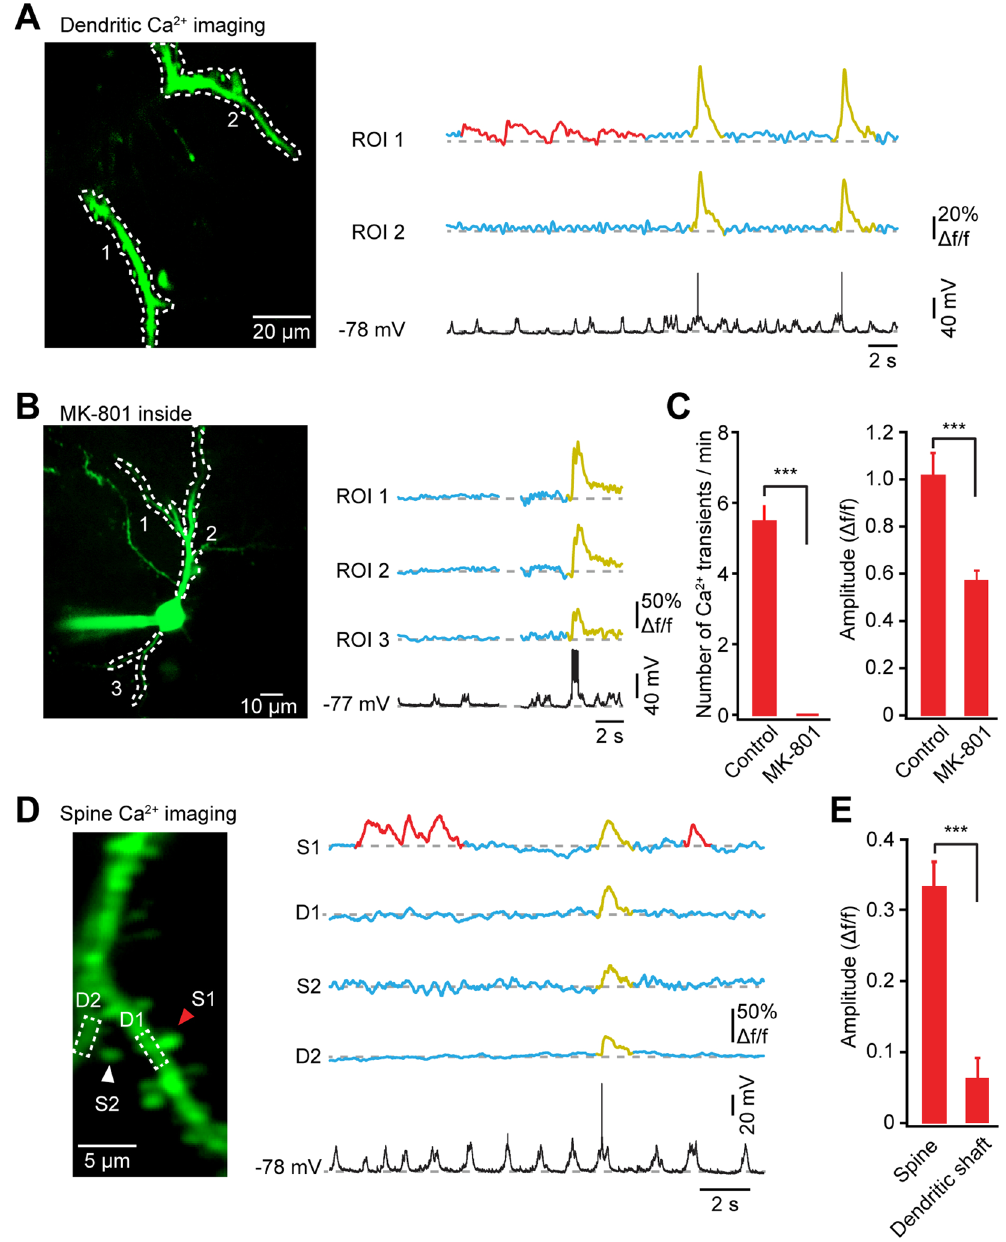
Figure 5. Local Ca 2 + signals associated with synaptic activation in dendrites and spines. ( A ) Subthreshold local dendritic Ca 2 + signals. Left, two-photon image with ROIs from the same neuron as in Fig. 3A. Right, local dendritic Ca 2 + signals (in red) and AP-associated dendritic Ca 2 + signals (in yellow), and their corresponding electrical signals recorded from the soma (in black). (B) Blockade of local dendritic Ca 2 + signals by intracellularly applied MK-801 (1 mM). Note that AP-associated Ca 2 + signals were still present, obtained from the same neuron in Fig. 4D. ( C ) Comparison of number of subthreshold dendritic Ca 2 + transients (Left) and amplitude of single AP-associated dendritic Ca 2 + transients (right) without (control: n = 10 dendrites from 5 neurons) and with MK-801 ( n = 8 dendrites from 3 neurons). Wilcoxon rank sum test, *** P < 0.001. Error bar shows SEM. (D) Subthreshold spine Ca 2 + signals. Left, two-photon image of a dendritic segment, obtained from the same neuron as in Fig. 3A. Right, Ca 2 + signals from two spines (marked by arrowheads) and their dendritic shafts (outlined by dotted boxes) in this dendritic segment, and the corresponding somatic electrical signals. Local Ca 2 + signals are marked in red, while AP-associated signals are marked in yellow. (E) Summary of the amplitude of local Ca 2 + transients in spines and in their dendritic shafts (10 spines from 3 neurons). Wilcoxon signed rank test, *** P <